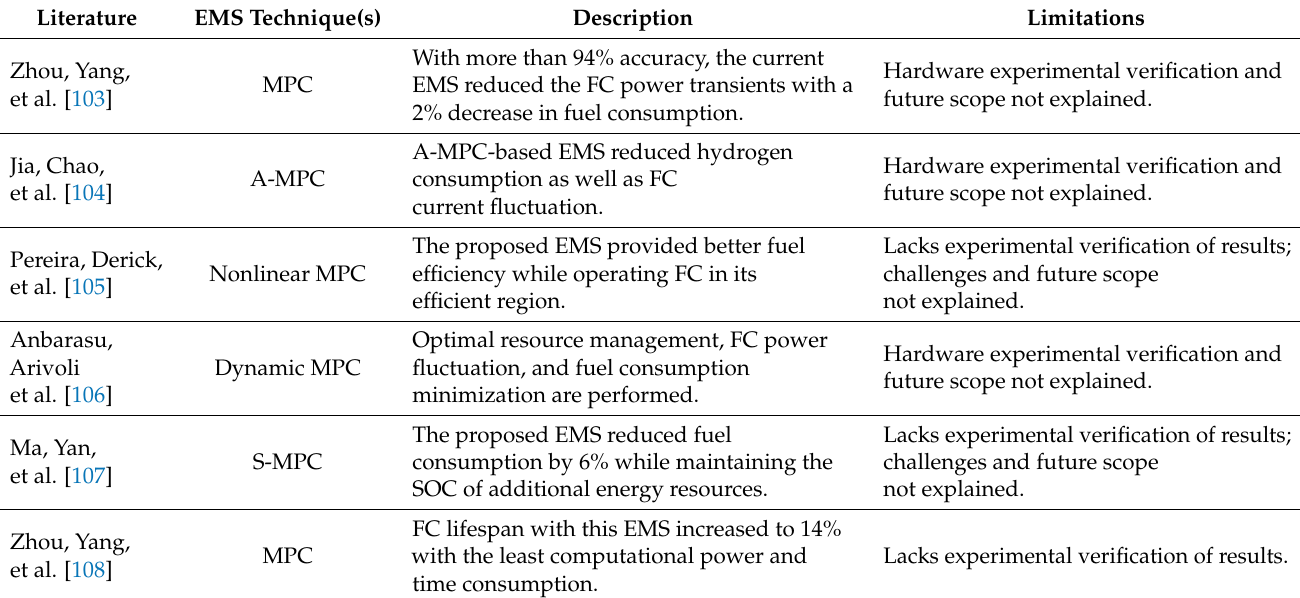
Table 11. Summary of the latest literature related to MPC-based EMSs.